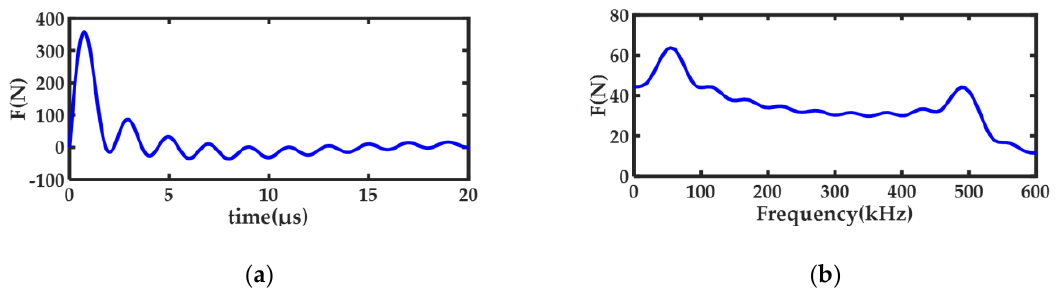
Figure 5. Load characteristics: ( a ) time domain; ( b ) frequency domain.